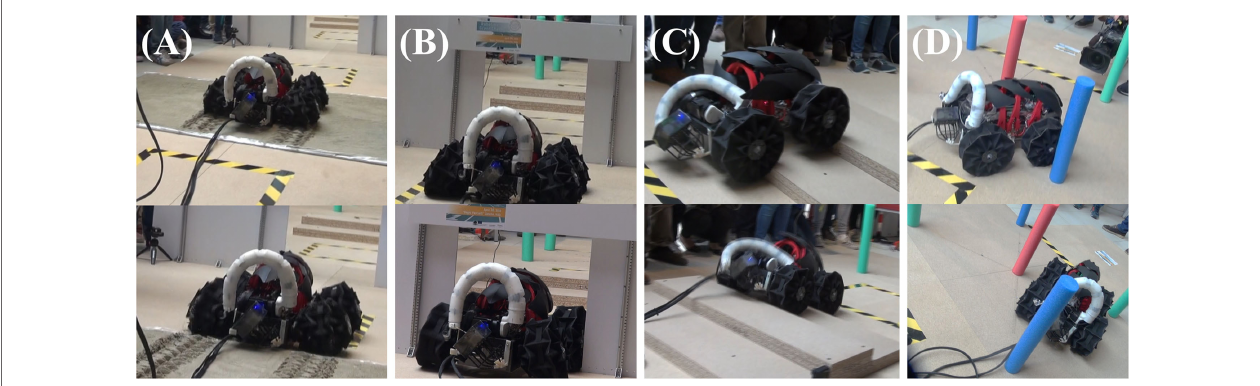
FigUre 11 | Performance during the four terrestrial navigation scenario tasks . (a) Crossing sand terrain: enlarging SNUMAX’s wheels allowed it to overcome a small bump and move on sand terrain. (B) Passing through a small aperture: shrinking SNUMAX’s wheels allowed it to pass through a small aperture. (c) Ascending and descending stairs: enlarging SNUMAX’s wheels allowed it to ascend and descend stairs. (D) Passing between unstable obstacles: the robot was carefully maneuvered between unstable poles without touching them while narrowing the wheels.